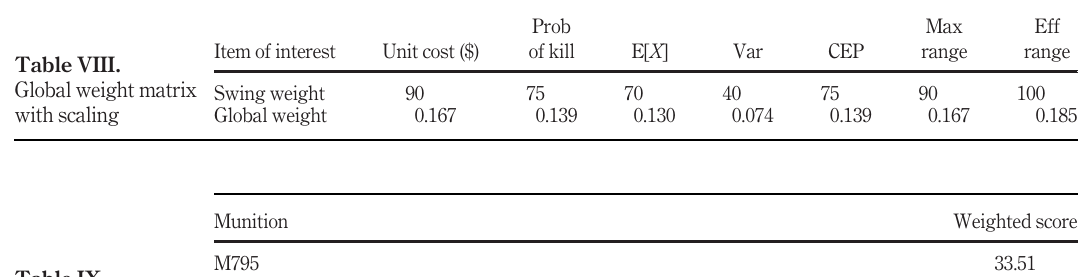
Table IX. Weighted scores for each projectile